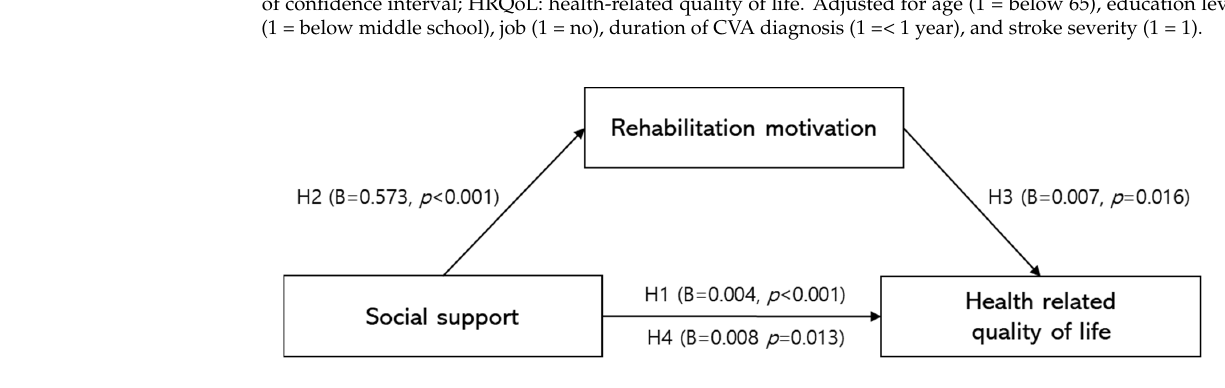
Figure 1. Mediating effect of rehabilitation motivation in patient with stroke. Adjusted for age (1 = below 65), education level (1 = below middle school), job (1 = no), duration of CVA diagnosis (1 =< 1 year), stroke severity (1 =